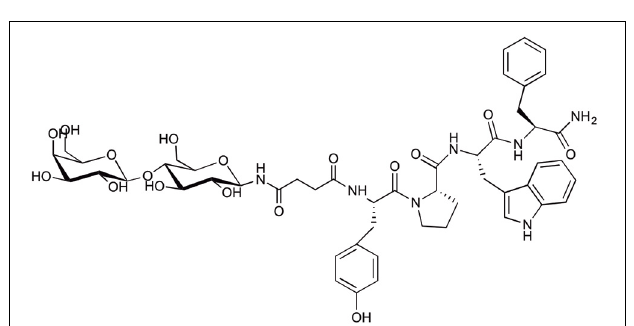
FIGURE 6 | Structure of lactose succinamic acid-conjugated endomorphin-1.